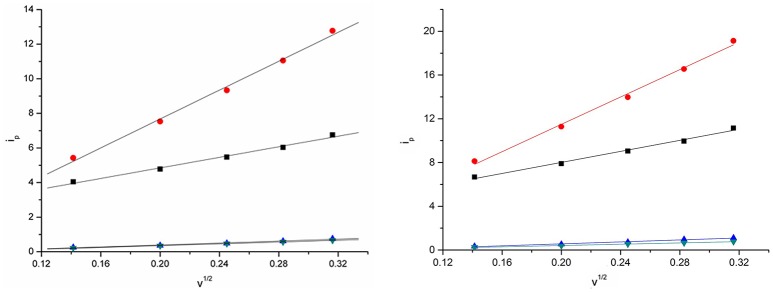
Cathodic peak current intensities as a function of ν1/2 of Eu(III) measured in [C4mim][N(CN)2] (black), [C4m2im][N(CN)2] (red), N4442[N(CN)2] (blue), and N8444[N(CN)2] (green) at 303 K (left) and 333 K (right).